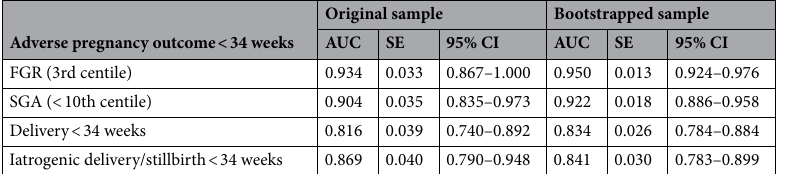
Table 3. Observer area under the curve (AUC) and optimism adjusted AUC after 1000-fold bootstrapping for adverse outcomes before 34 weeks’ gestation. AUC area under curve, SE standard error, CI confidence interval, FGR fetal growth restriction, SGA small for gestational age.